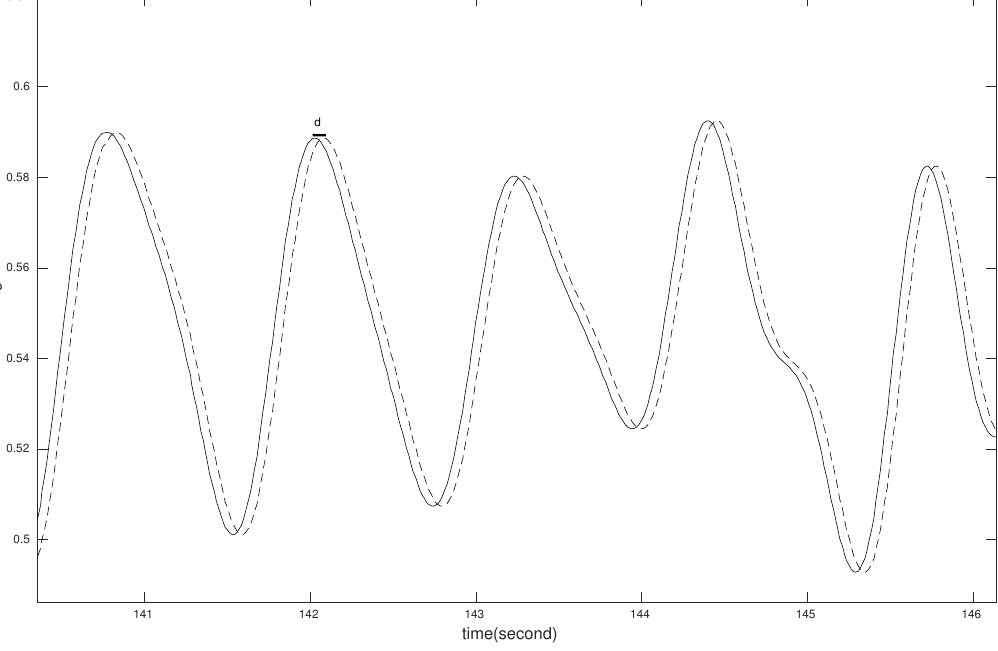
Figure 5. Time difference between EMG recording (solid line) and input spread function n ( t ) (dashed line, input for motor response) against time. The two functions are separated by electromechanical delay time d